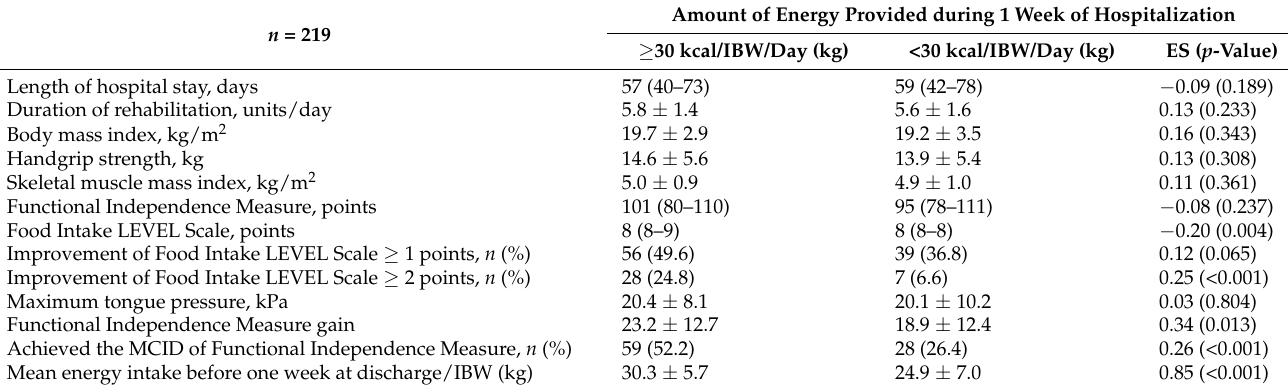
Table 3. Comparison of the variables at discharge in the IPTW